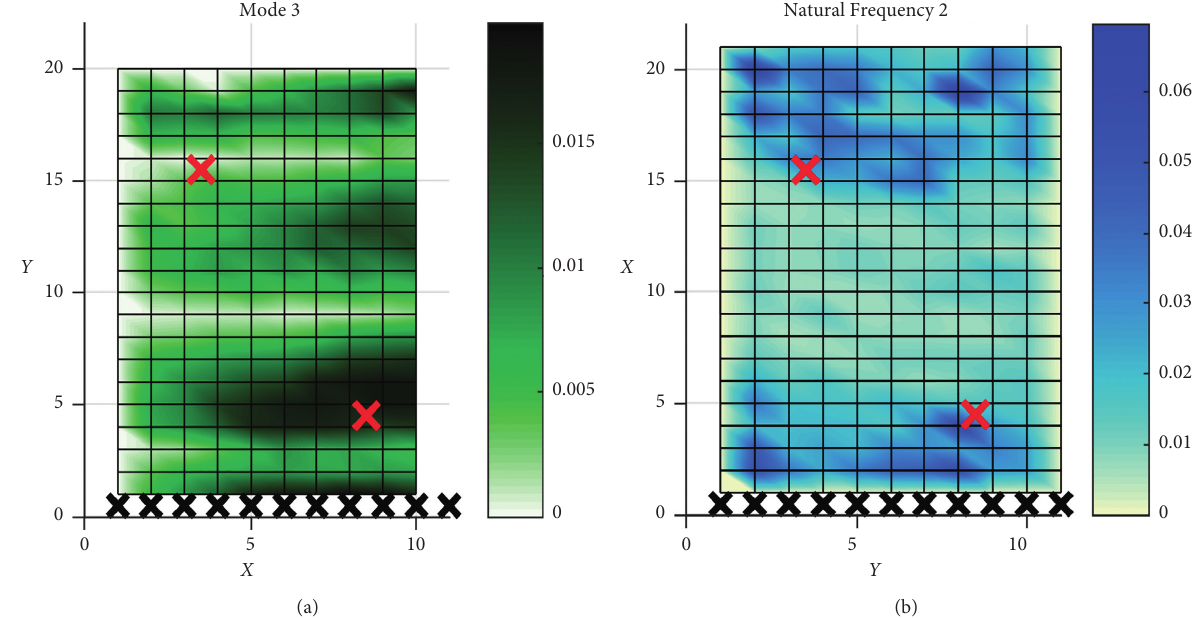
Figure 15: An example of positive localization results obtained using (a) the WV method and (b) the LMF